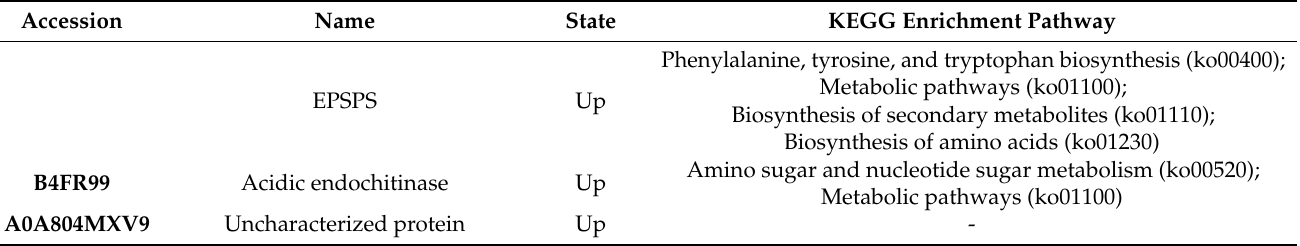
Table 4. The DEPs among the three GM maize